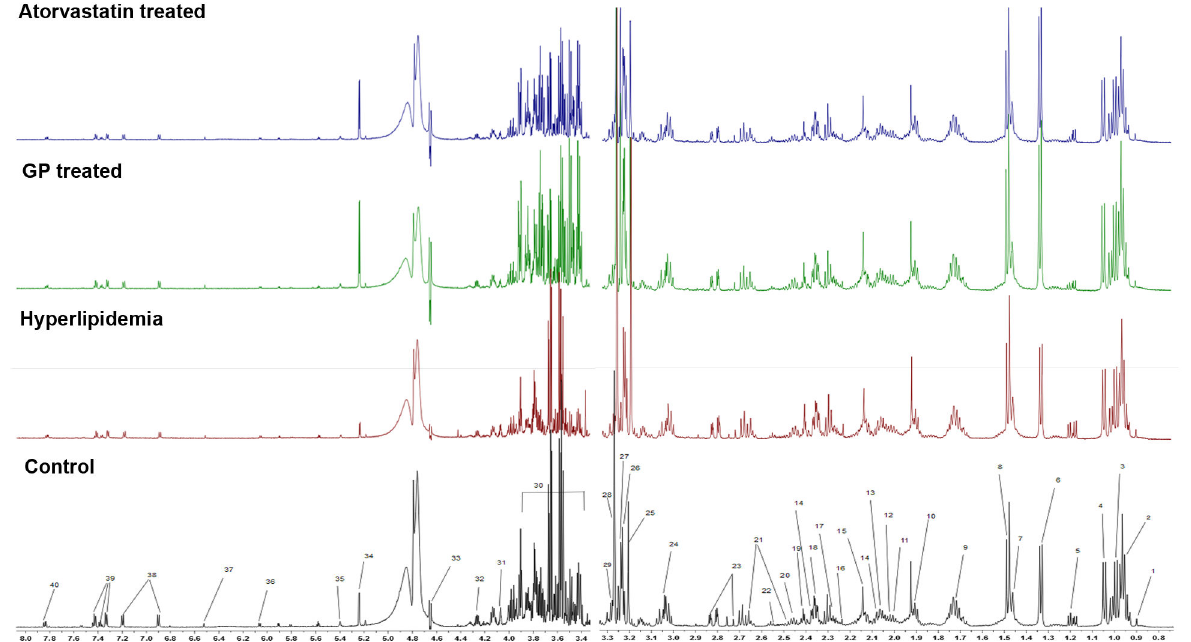
Figure 2. Typical 600 MHz 1 H-NMR spectra of rat liver samples. 1. Lipids (VLDL/LDL) 2. Leucine 3. Isoleucine 4. Valine 5.3- Hydroxybutyrate 6. Lactate 7. Alanine 8. Lysine 9. Arginine 10. Acetate 11. Proline 12. N-Acetyl glycoproteins 13. O-Acetyl glycoproteins 14. Glutamate 15. Methionine 16. Acetoacetate 17. Acetone 18. Succinate 19. Pyruvate 20. Glutamine 21. Citrate 22. Glutathione 23. Aspartate 24. Creatine 25. Phosphatidylcholine 26. Choline 27. Phosphocholine/GPC 28. TMAO 29. Taurine 30. Glucose/aminoacids resonances 31.myo–Inositol 32. Threonine 33. β-Glucose 34.α-Glucose 35. Glycogen 36. Adenosine/Inosine 37. Fumarate 38. Tyrosine 39. Phenylalanine 40. Histidine. doi: